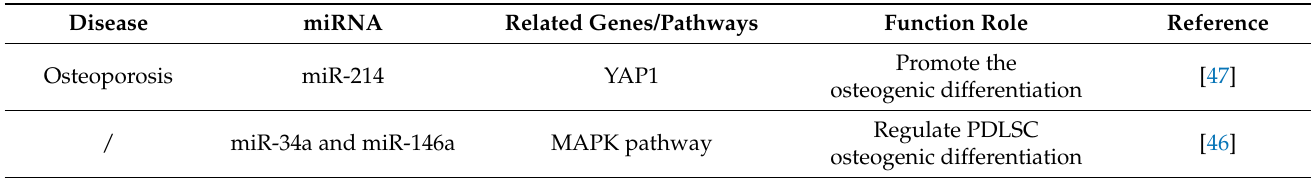
Table 2. Target and role of circ-ITCH in cell